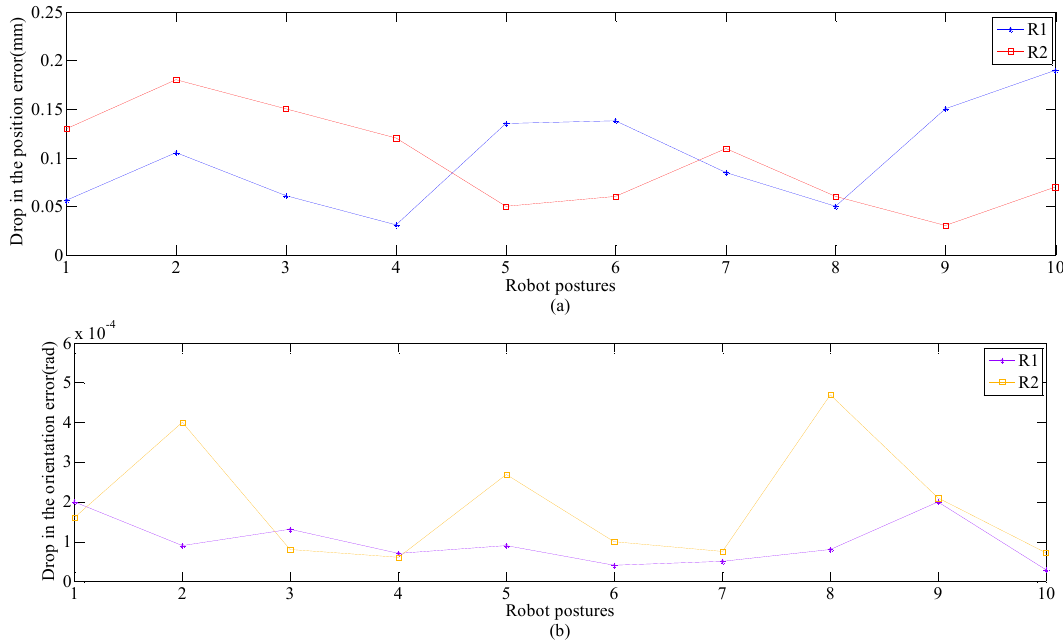
Figure 9. The drop in the pose error of the EE. ( a ) Drop in the position error; ( b ) Drop in the orientation error.